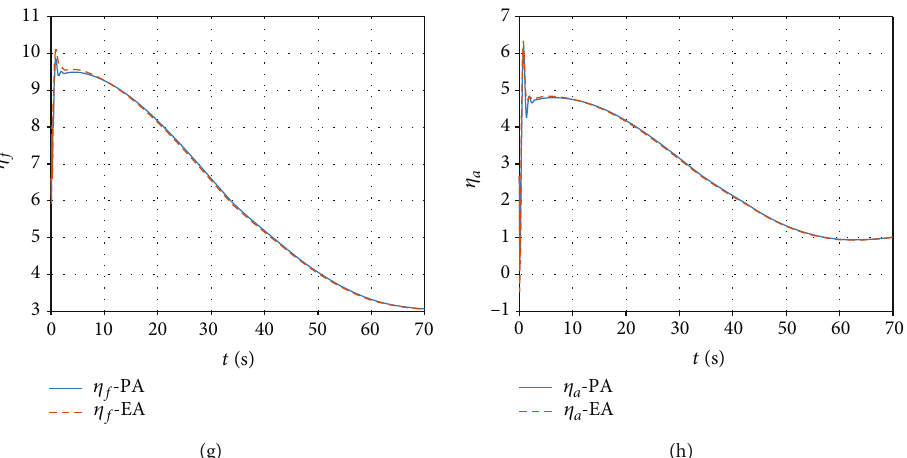
Figure 4: Response of SCFDM with disturbances and perturbation. (a) The response of velocity. (b) The response of the angle of attack. (c) The elevator de fl ection. (d) The equivalence ratio. (e) The altitude. (f) The pitch angle. (g) The generalized modal coordinate of the forward beam. (h) The generalized modal coordinate of the afterward